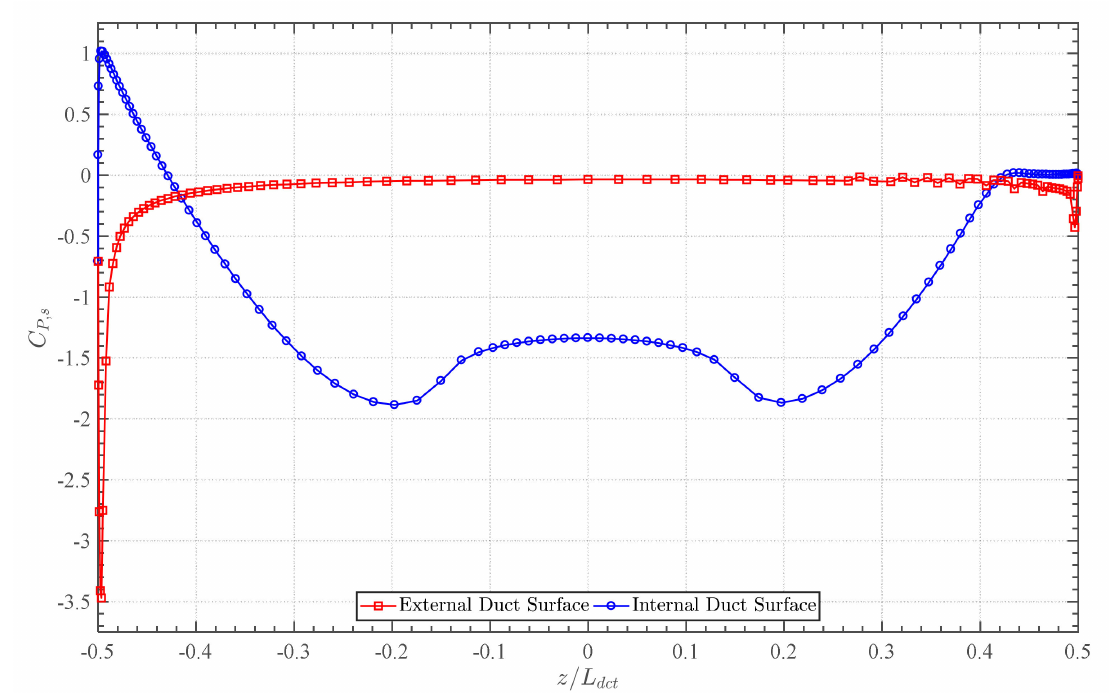
Figure 8. Pressure coefficient ( C P , s ) values along the external straight and internal curved duct surfaces ( U ∞ = 4 m.s − 1 ; γ = 0 ◦ ).